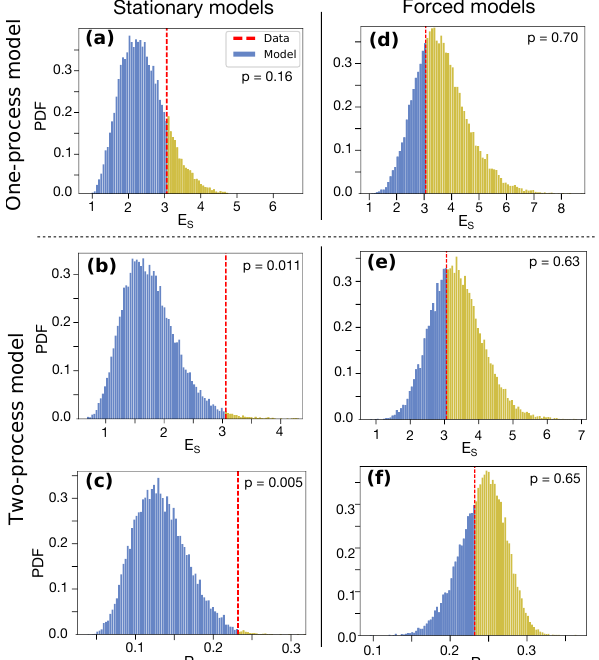
Figure 3. Empirical distributions from Monte Carlo simulation of the test statistics for the stationary (a–c) and the forced null model (d–f) . The test statistics E S of the one-process models are shown in panels (a) and (d) . The test statistics E S and P S of the two-process models are shown in panels (b) and (e) , and (c) and (f) , respec- tively. The position of the data test statistic within the distribution is marked in red and determines the p value of the hypothesis tests.